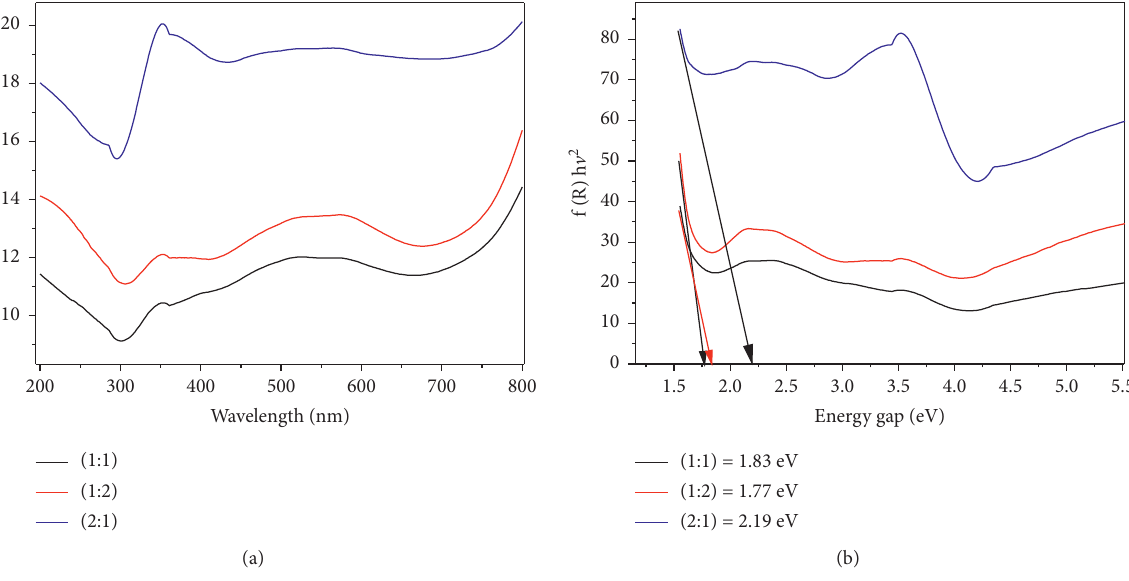
Figure 6: DRS spectra of green-synthesized Co 3 O 4 NPs (a) and their corresponding band gap energy